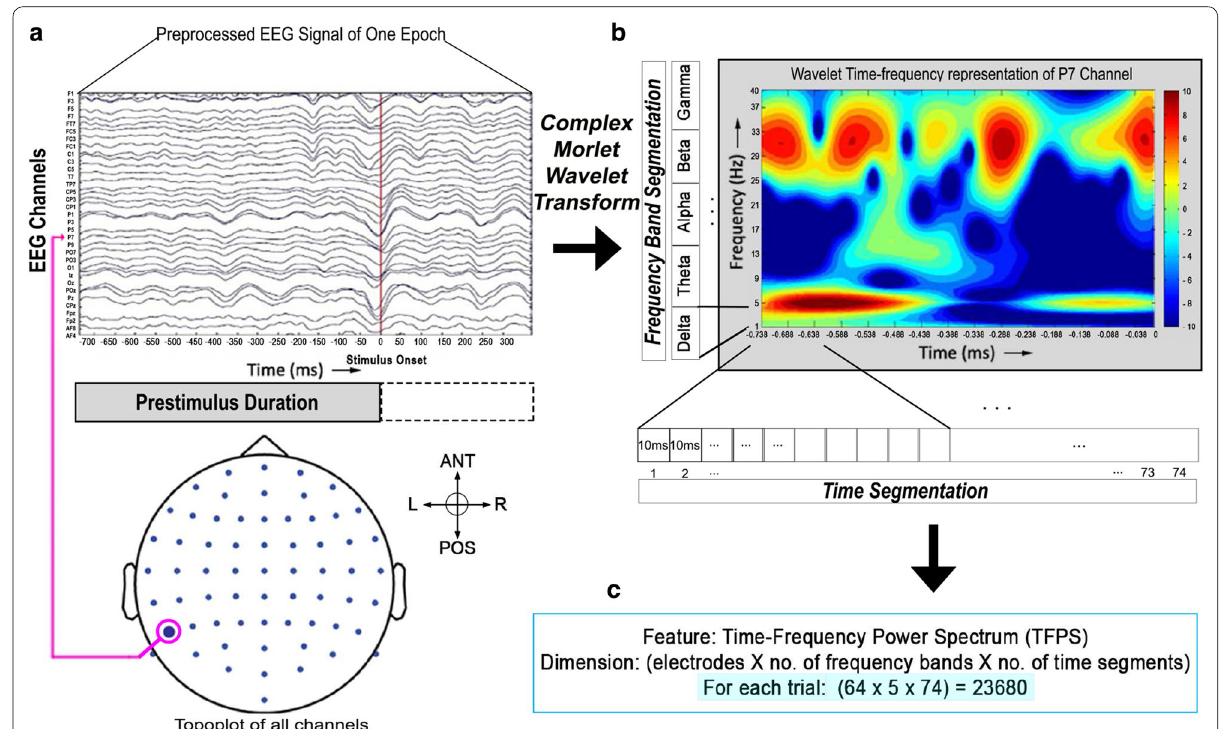
Fig. 3 Feature extraction procedure: a A typical epoch of EEG channels. Red vertical line denotes stimulus onset. b Time–frequency representation (TFR) of one EEG channel (here P7, chosen randomly) obtained by convoluting the EEG signal with complex Morlet wavelet. The prestimulus period was segmented into nonoverlapping 74 short windows of 10 ms each. Similarly, frequency band segmentation also produced five segments by band-wise averaging of each frequency point within individual frequency band (see Materials and methods ). c Feature dimension of time–frequency power spectrum (TFPS) that was extracted from all 64 EEG